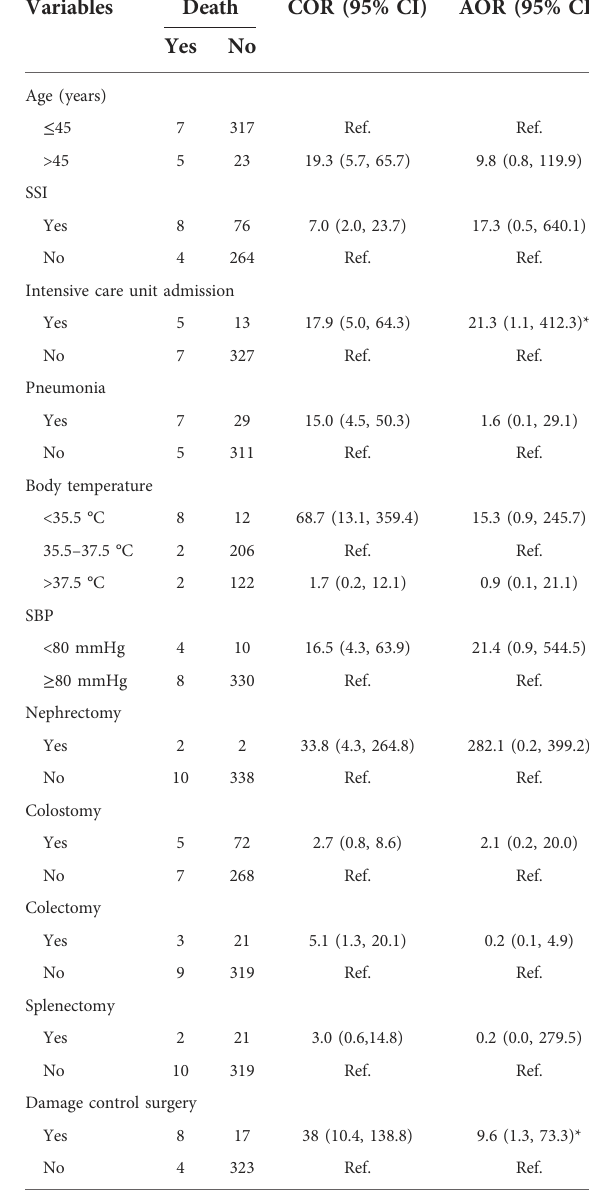
TABLE 4 Bivariable and multivariable binary logistic regression analyses for factors associated with death due to penetrating abdominal trauma during 2015 – 2019 at HFSUH, eastern